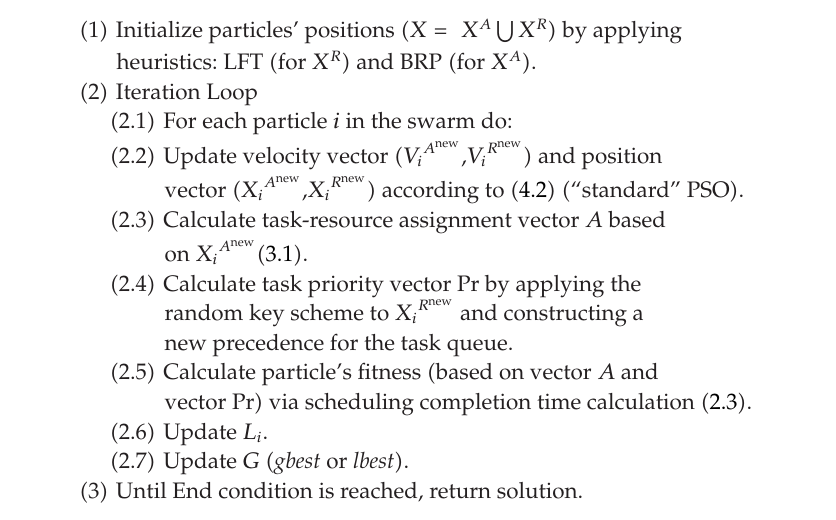
Algorithm 2: The pseudocode of the proposed enhanced PSO.